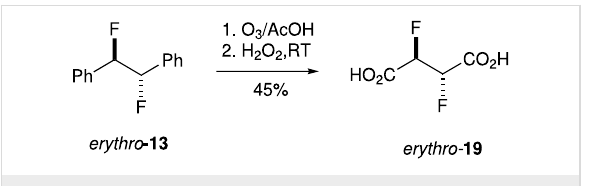
Scheme 8: Synthesis of erythro - 19 via ozonolysis of erythro - 13 . Figure 5: X-ray structure of erythro - 19